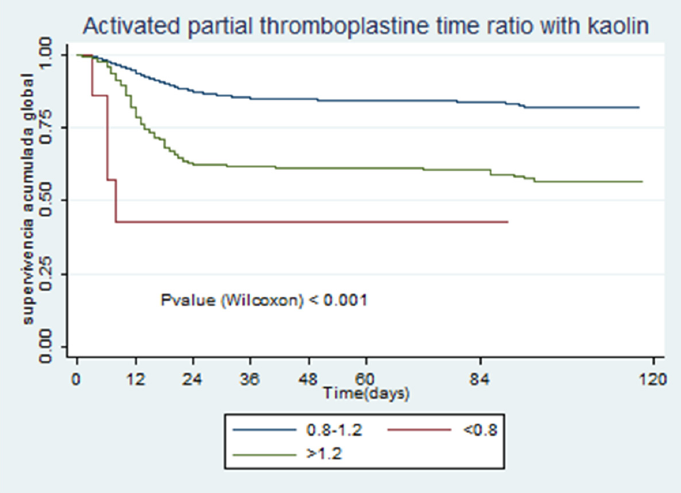
Figure 5. Activated partial thromboplastin time ratio with kaolin.